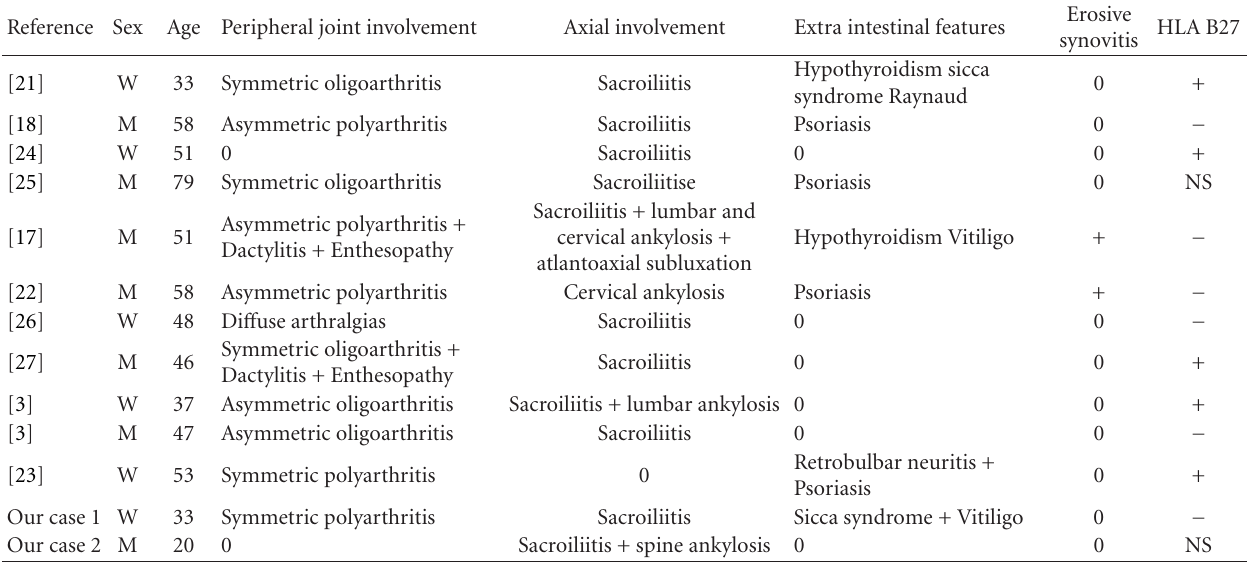
Table 1: Characteristics of the 11 cases with CC and SpA and ours